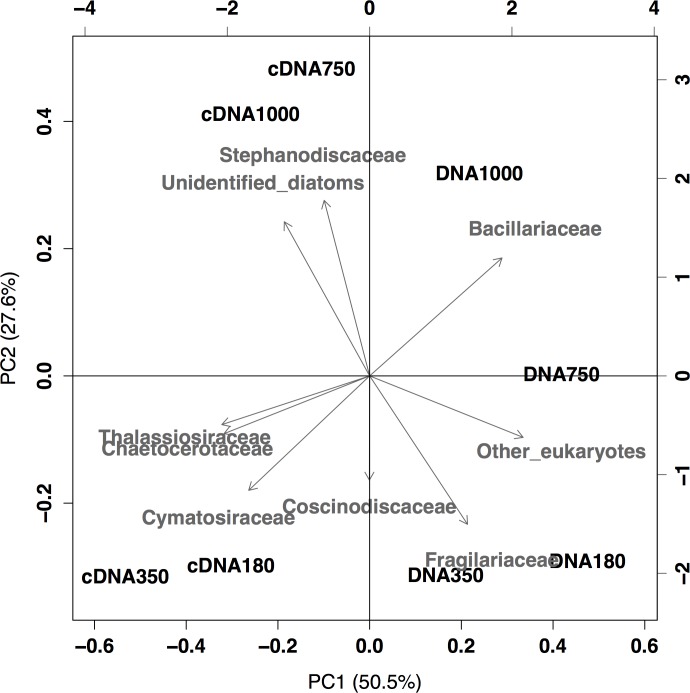
Principal component analysis (PCA) ordination plots incorporating relative contribution of sequence reads for pCO2 treatments in the DNA and cDNA libraries on day 3.Each sample is represented as the library type followed by the pCO2 treatments (i.e., DNA180 indicates the DNA sample from the 180 μatm CO2 treatment).